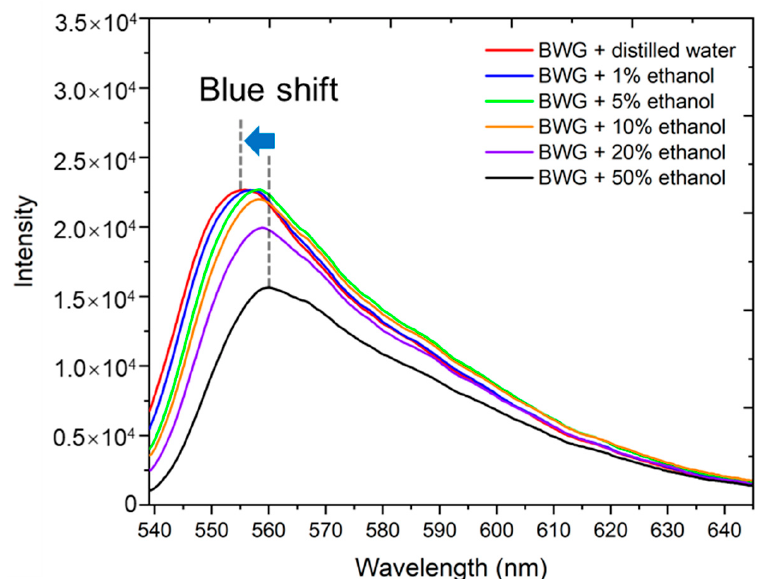
Figure 8. The spectra of laser radiation transmitted through the BWG with ethanol solutions deposited on the PG surface. The concentrations by volume of the ethanol solutions are 50%, 20%, 10%, 5%, and 1%, and 0% indicates distilled water.